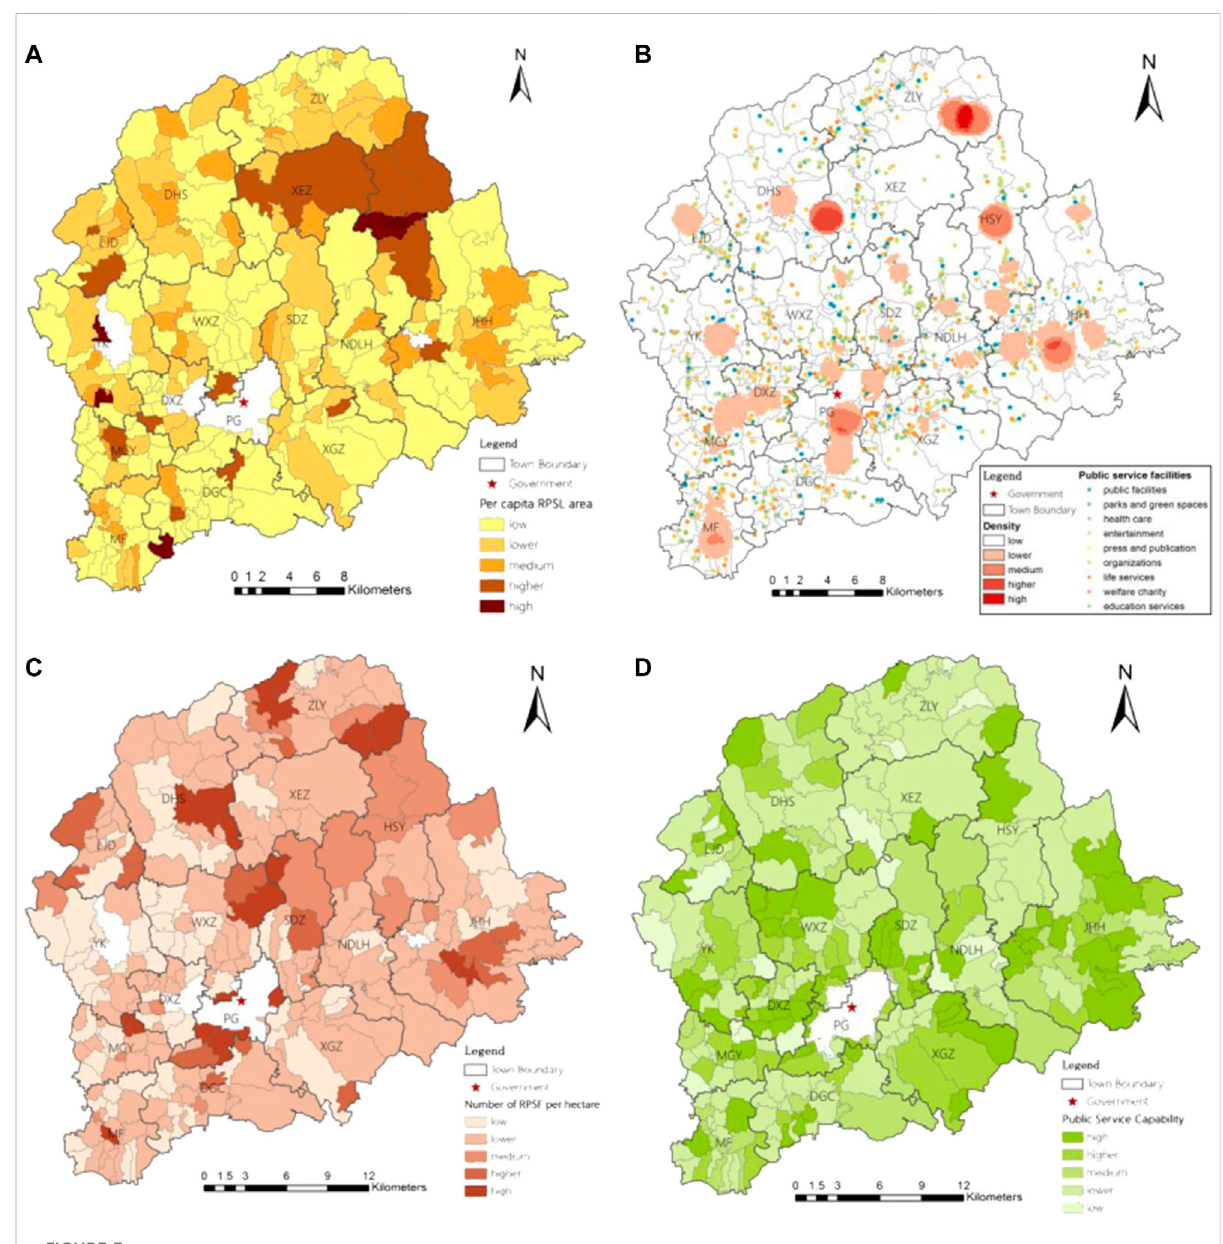
FIGURE 3 The public service values of RPSL in